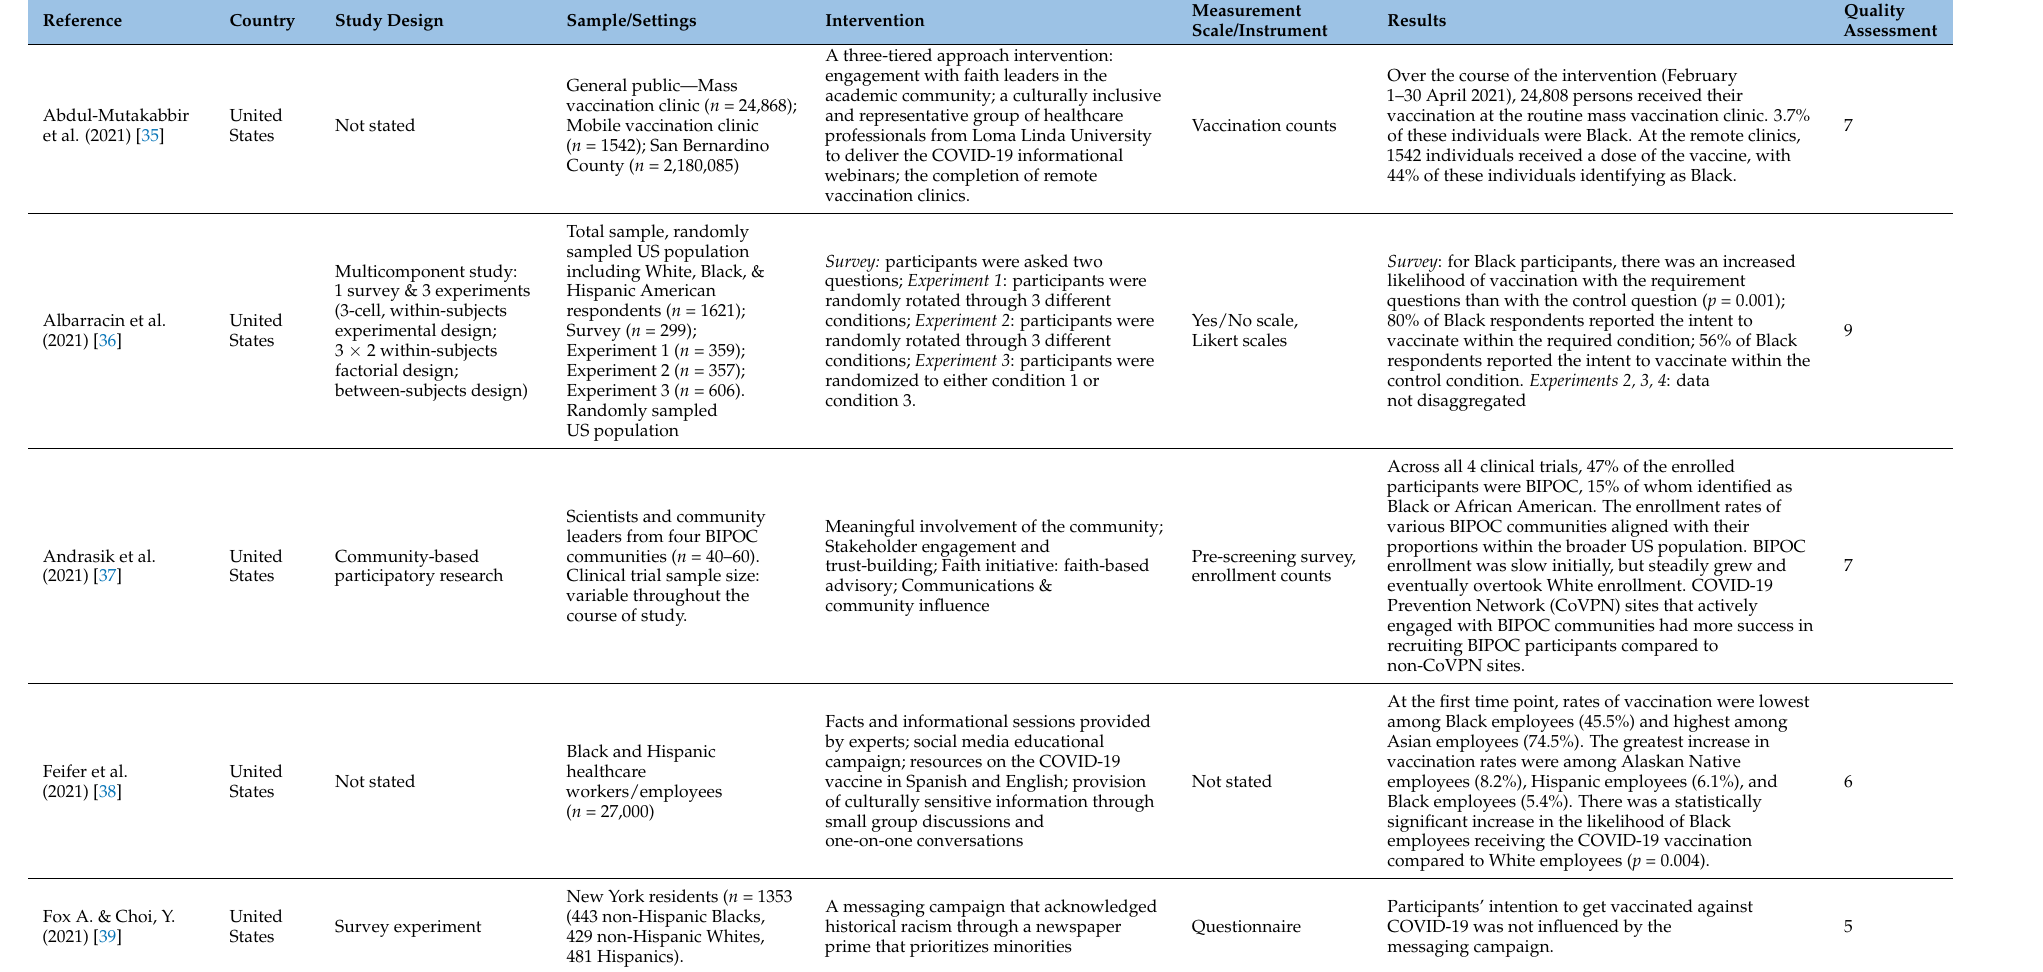
Table 2. Characteristics of included